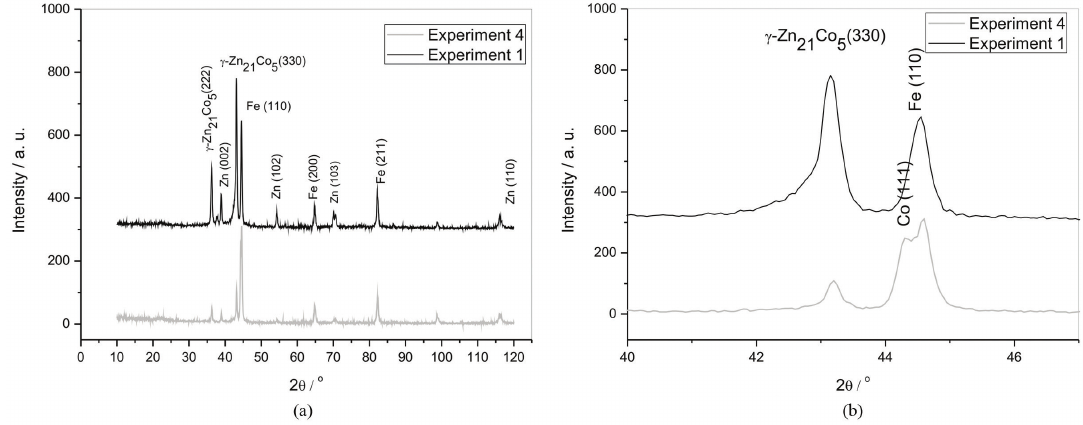
Figure 8. (a) XRD analysis of the coatings produced from experiments 1 and 4 (Table 2); (b) Magnification of Figure (a).